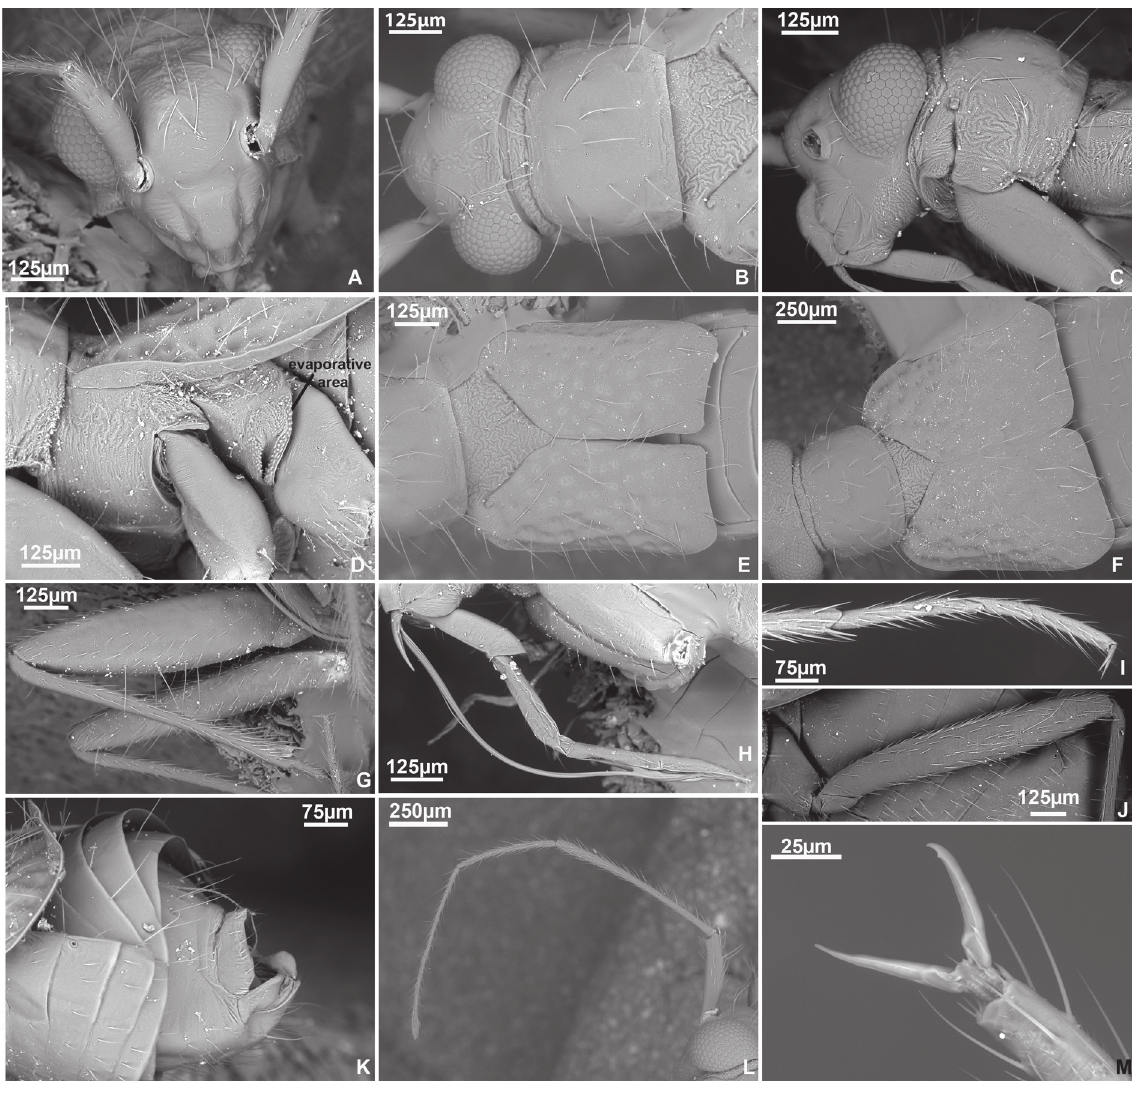
Fig. 4. SEM images of C. parvum sp. nov. A . Head, anterior view, ♀. B . Head and pronotum, dorsal view, ♂. C . Head and pronotum, lateral view, ♂. D . Pleura, ♀. E . Scutellum and hemelytra, ♂. F . Scutellum and hemelytra, ♀. G . Fore- and middle femora, ♀. H . Labium, ♂. I . Hind tarsus, ♀. J . Hind femur, ♀. K . Genital segment, lateral view, ♂. L . Antenna, ♀. M . Pretarsus,